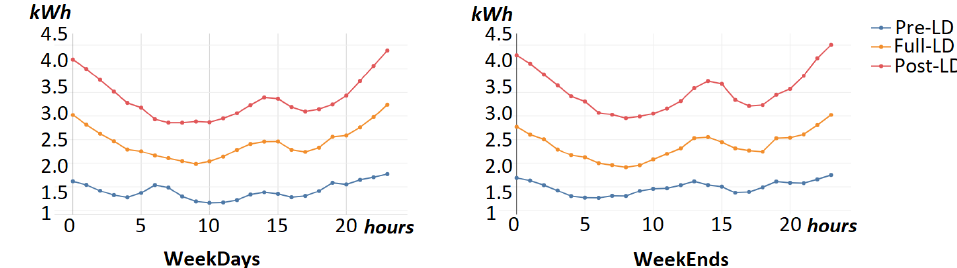
Figure 11. Mean hourly consumption profiles for weekdays/weekends during the lockdown period in